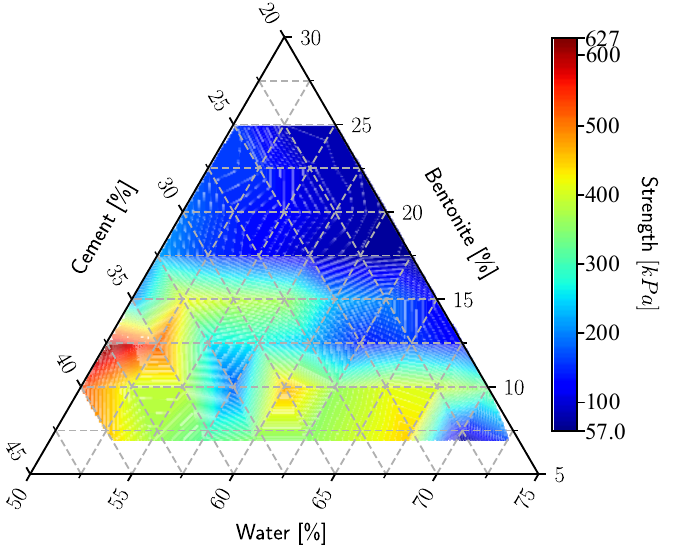
Figure 6. Axial compressive strength.